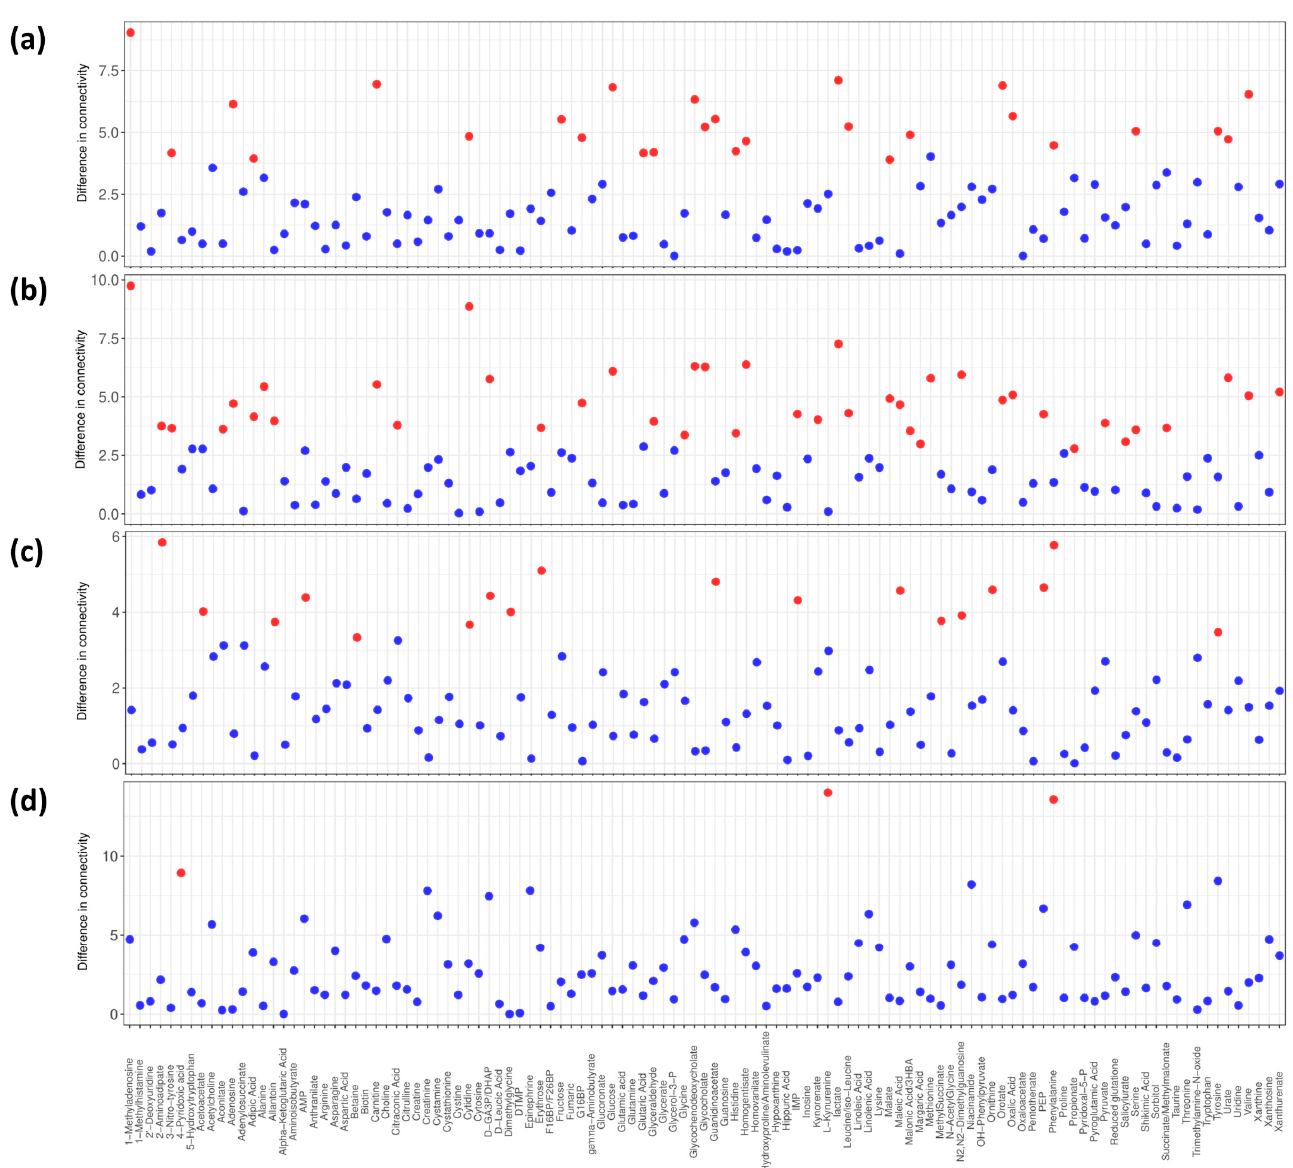
Figure 4. Differential connectivity analysis. Differences in terms of connectivity in metabolite-metabolite association networks of ( a ) CRC and CTR groups; ( b ) CRC and PP groups; ( c ) PP and CTR groups; ( d ) colon cancer and rectal cancer sub-groups. Blue dots correspond to a not statistically significant metabolite and red dots correspond to a statistically significant metabolite. The threshold for significance of FDR corrected p -values ≤ 0.05 was imposed.